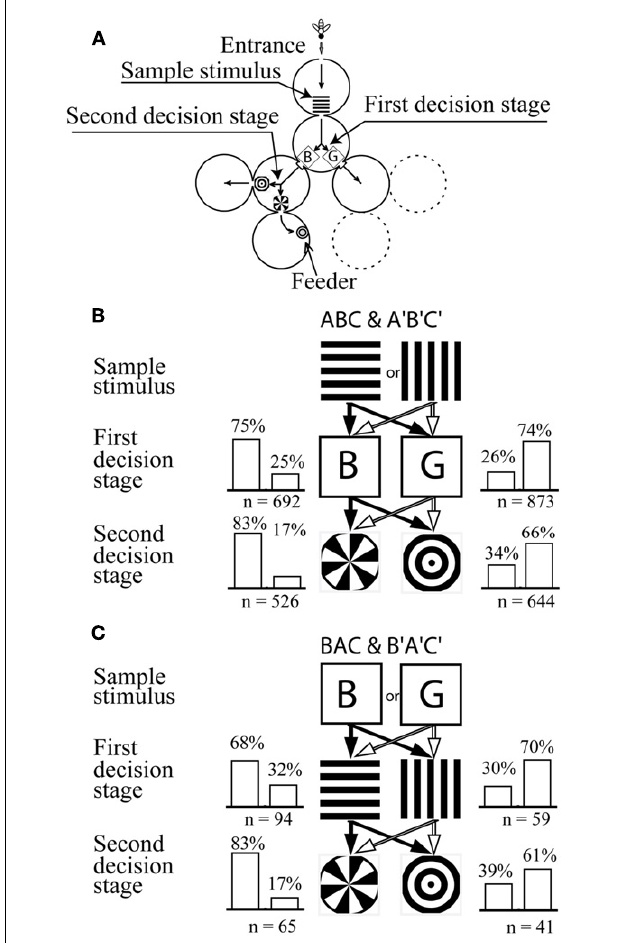
FIGURE 8 | Learning a symbolic-delayed-matching-to-sample task in the visual modality. (A) Y -maze setup with two decision stages. (B) Training stimulus configuration and training performance.The bees learned to choose horizontal-blue-sector or vertical-green-ring associations in order to get a reward. (C) Stimulus configuration and performance on the transfer test. Modified from Zhang et al. (1999). Details in text.